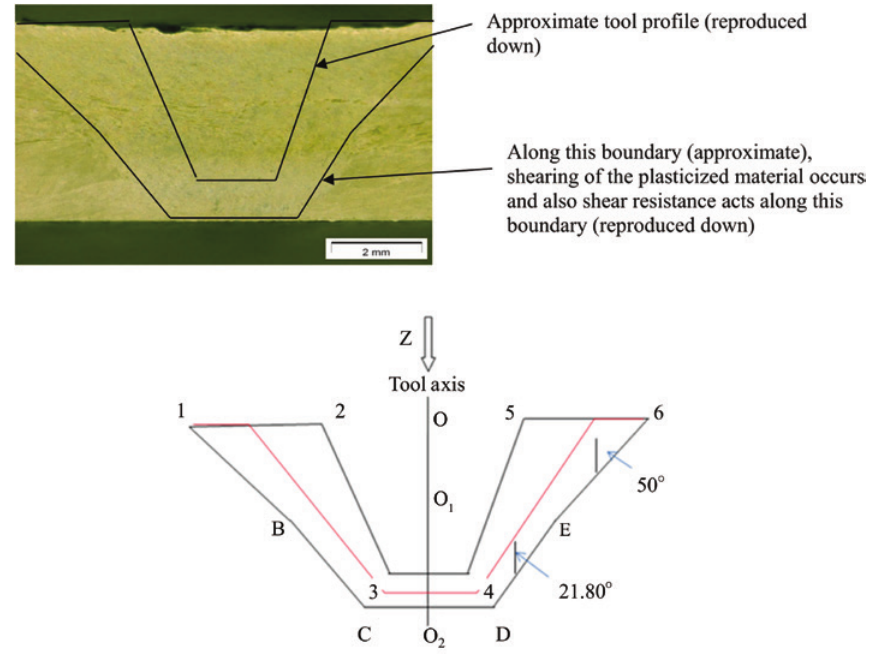
Figure 17: Tool profile and FSW volume cross section profile in friction stir welding of Mg